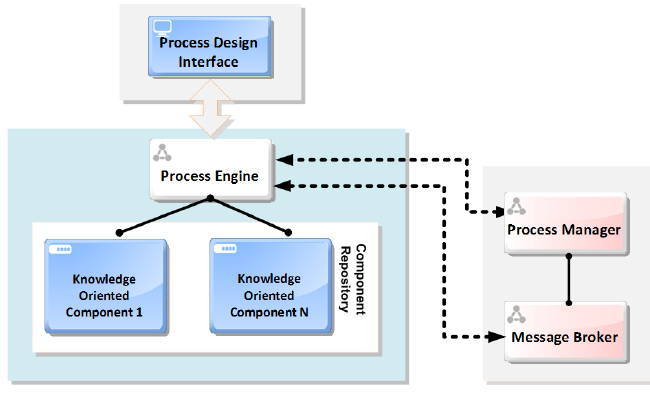
Figure 4. Activity Transaction